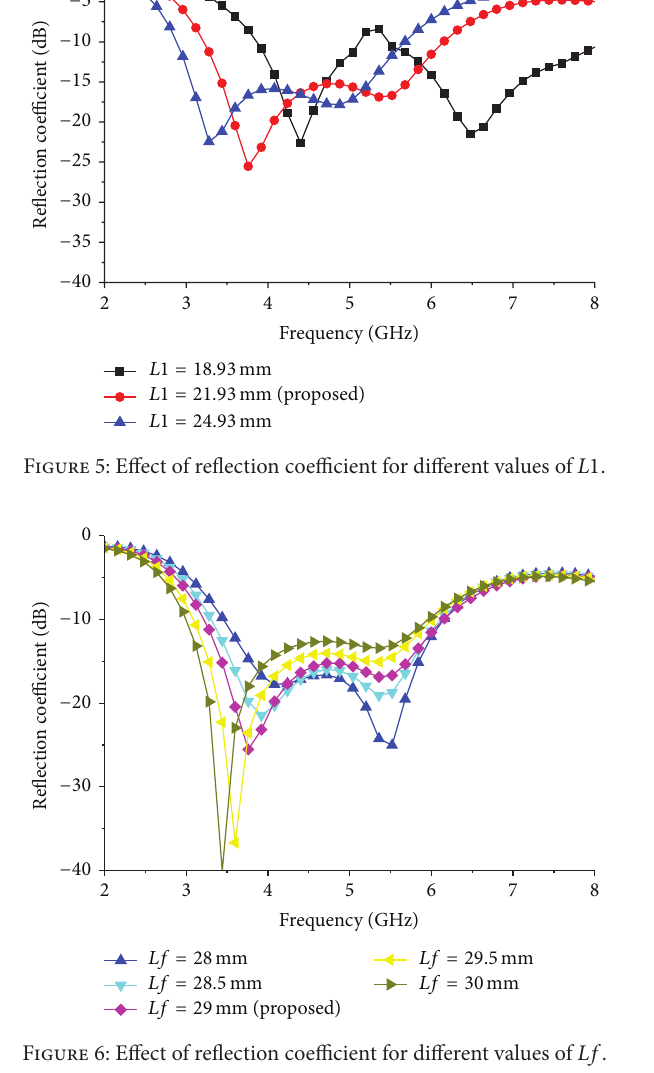
Figure 8: Effect of reflection coefficient with and without slot in ground